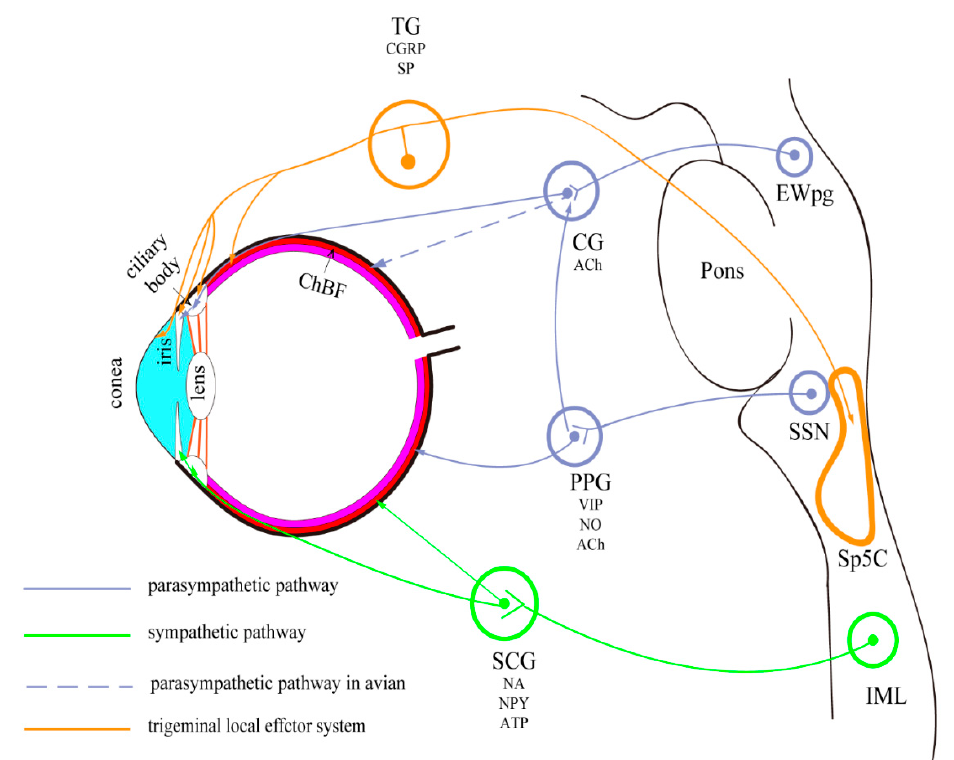
Figure 1. Autonomic pathways in mammals and avian. The encircled areas represent nuclei and ganglia. There are three autonomic pathways: (1) EW → CG → targets (parasympathetic pathway); (2) SSN → PPG → targets (parasympathetic pathway); (3) IML → SCG → targets (sympathetic pathway). Trigeminal nerve branches are also present. CG—ciliary ganglion; ChBF—choroidal blood flow; EWpg—nucleus of Edinger–Westphal; preganglionic division; IML—intermediolateral column; PPG—pterygopalatine ganglion; SCG—superior cervical ganglion; SSN—superior salivatory nucleus; TG—trigeminal ganglion.